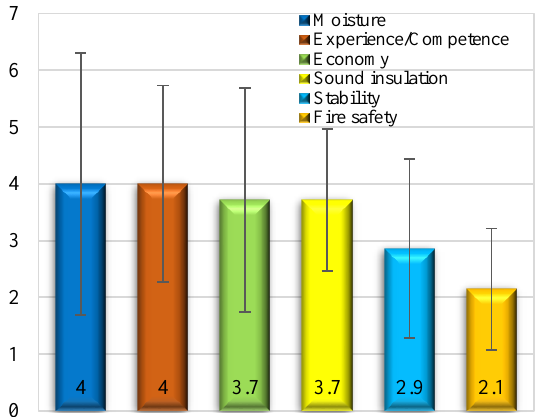
Figure 8. Ranking of influencing factors on decision of UERs not to choose wooden frames.